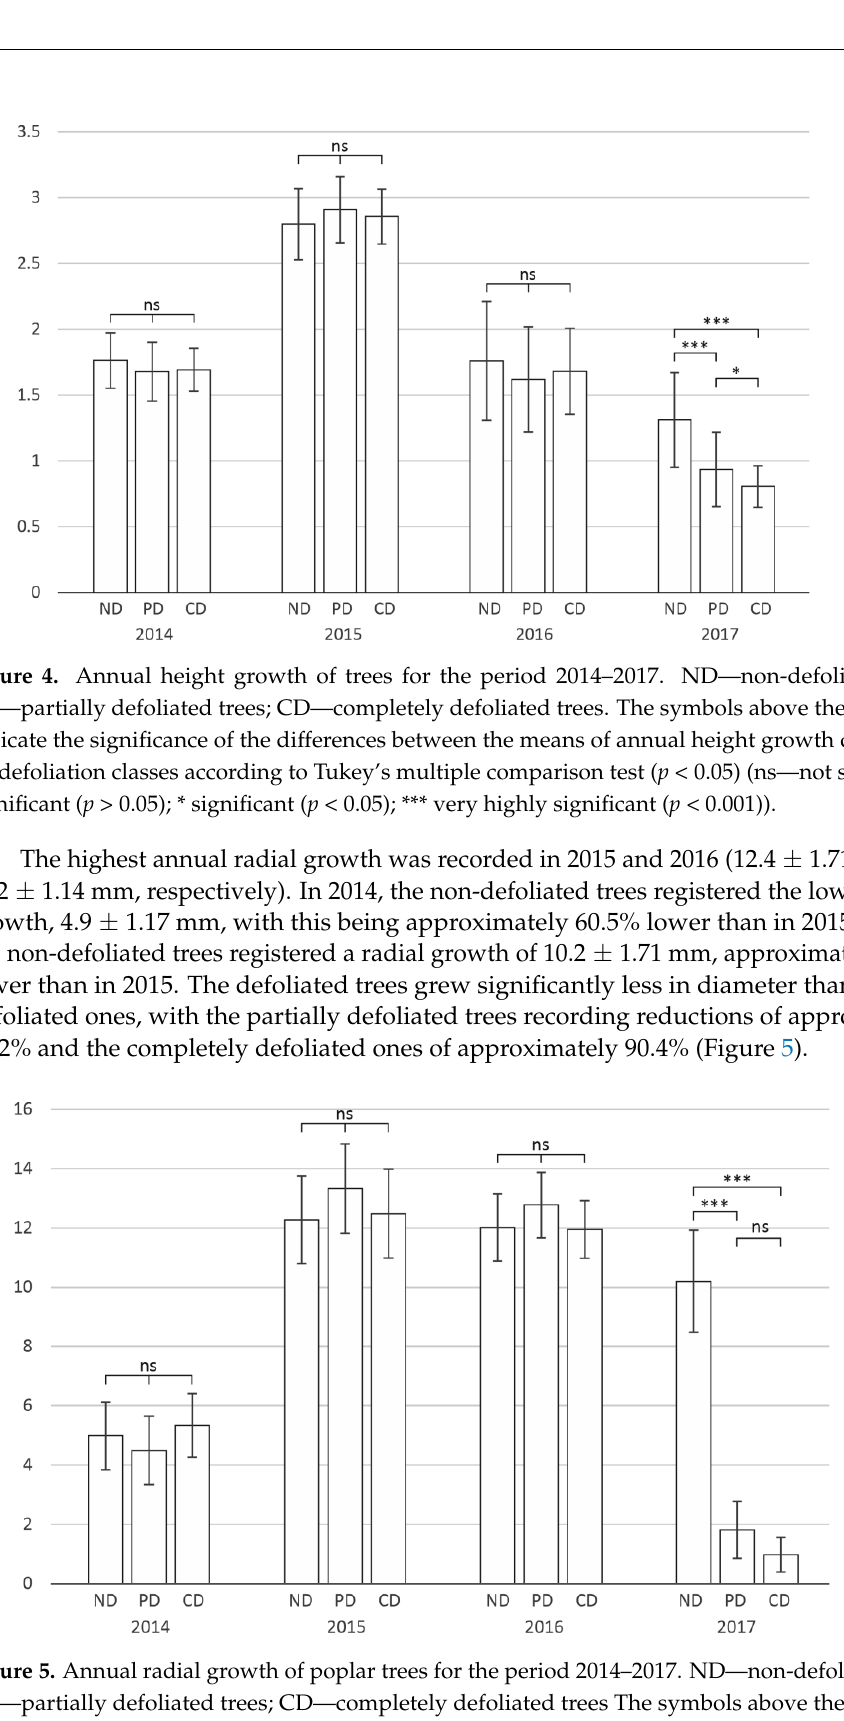
Figure 5. Annual radial growth of poplar trees for the period 2014–2017. ND—non-defoliated trees; PD—partially defoliated trees; CD—completely defoliated trees The symbols above the error bars indicate the significance of the differences between the means of radial height growth depending on defoliation classes according to Tukey’s multiple comparison test ( p < 0.05) (ns—not